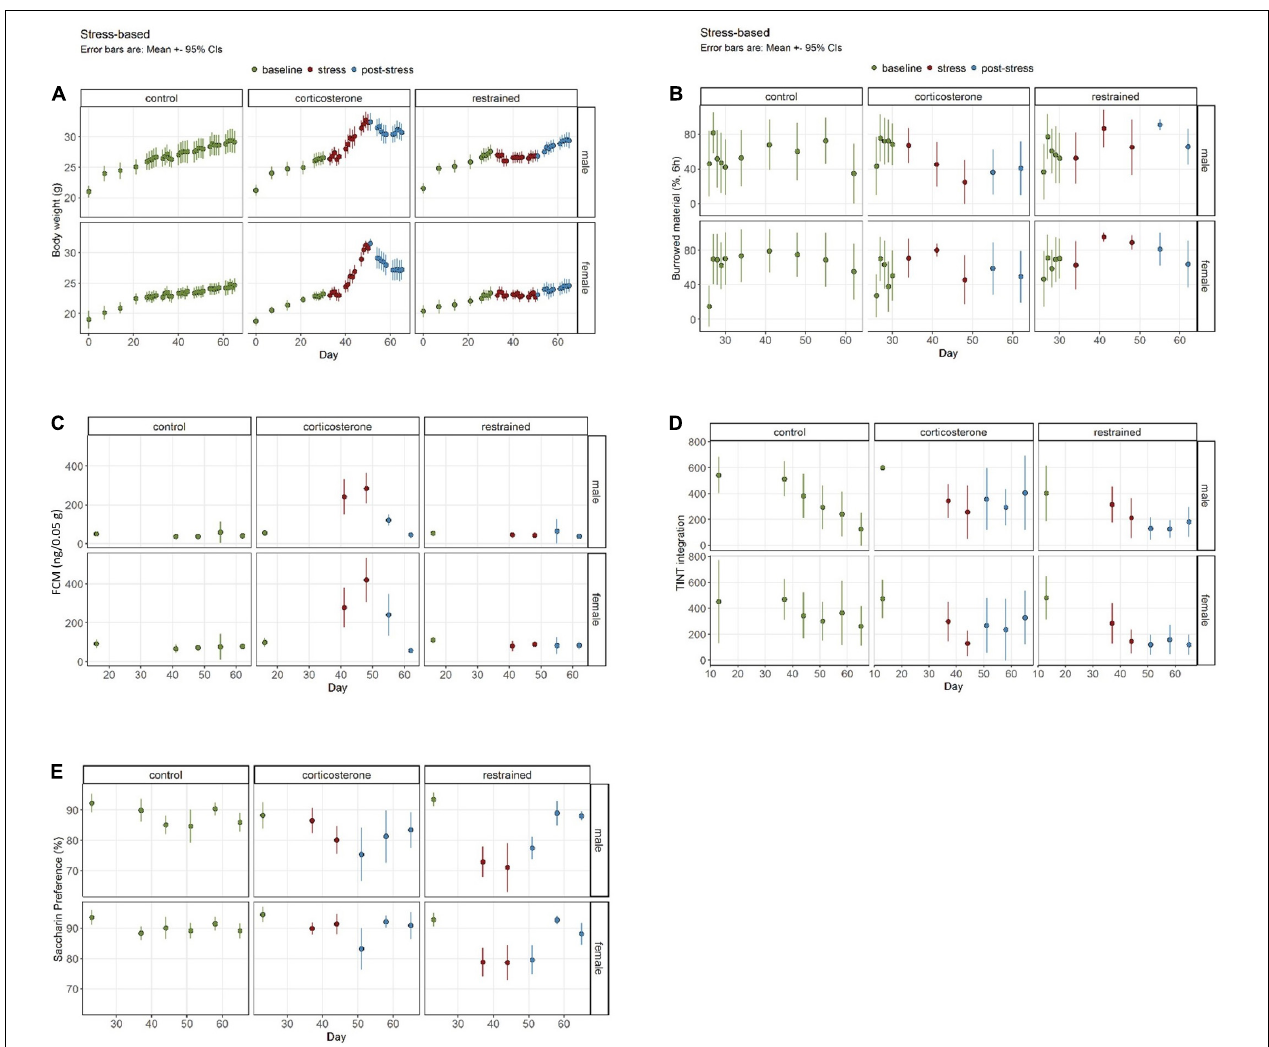
FIGURE 3 | Well-being-associated parameters in stress-based models. (A) Corticosterone intake increases body weight, while restraint causes diminished growth. (B) The burrowing performance was not influenced by restraint, but by corticosterone treatment. (C) Increased concentrations of fecal corticosterone metabolites (FCMs) are evident in the corticosterone group but not in the restrained animals or controls. (D) The latency to integrate new nesting material into the nest site is elevated in the corticosterone group in the post-stress-phase. (E) Interestingly, only a small and sex-dependent decrease of saccharin preference in corticosterone-treated mice is observable, while the restrained mice demonstrate a stronger effect. Data was analyzed using mixed linear models, n = 10 per group, except corticosterone n = 8, error bars are mean ± 95% ♀